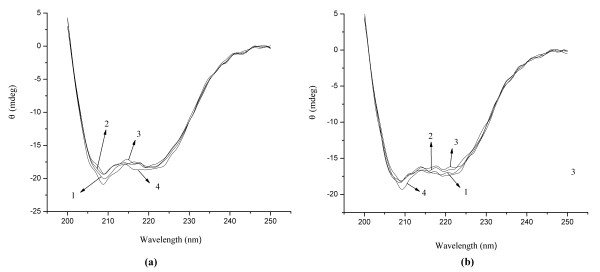
The CD spectra of HSA (a) and BSA (b). Conditions: HSA/BSA: 1.0 × 10-6 mol/L; C60: (1 to 4): 0, 2.78, 5.56, 11.12 × 10-6 mol/L; pH = 7.4.